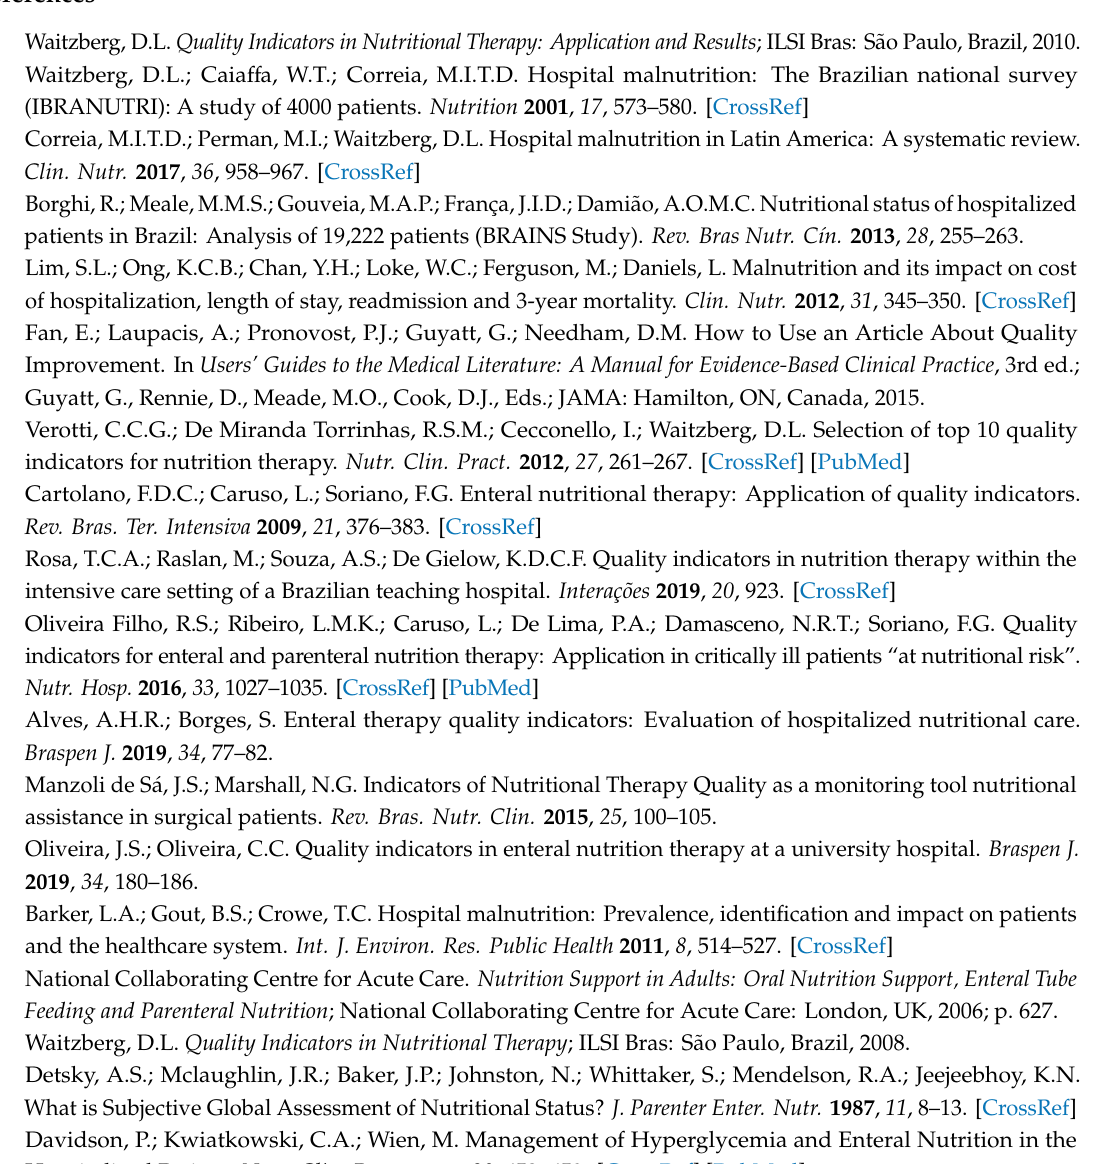
Table S1: Quality indicators in enteral and parenteral nutritional therapy, formulas, and proposed